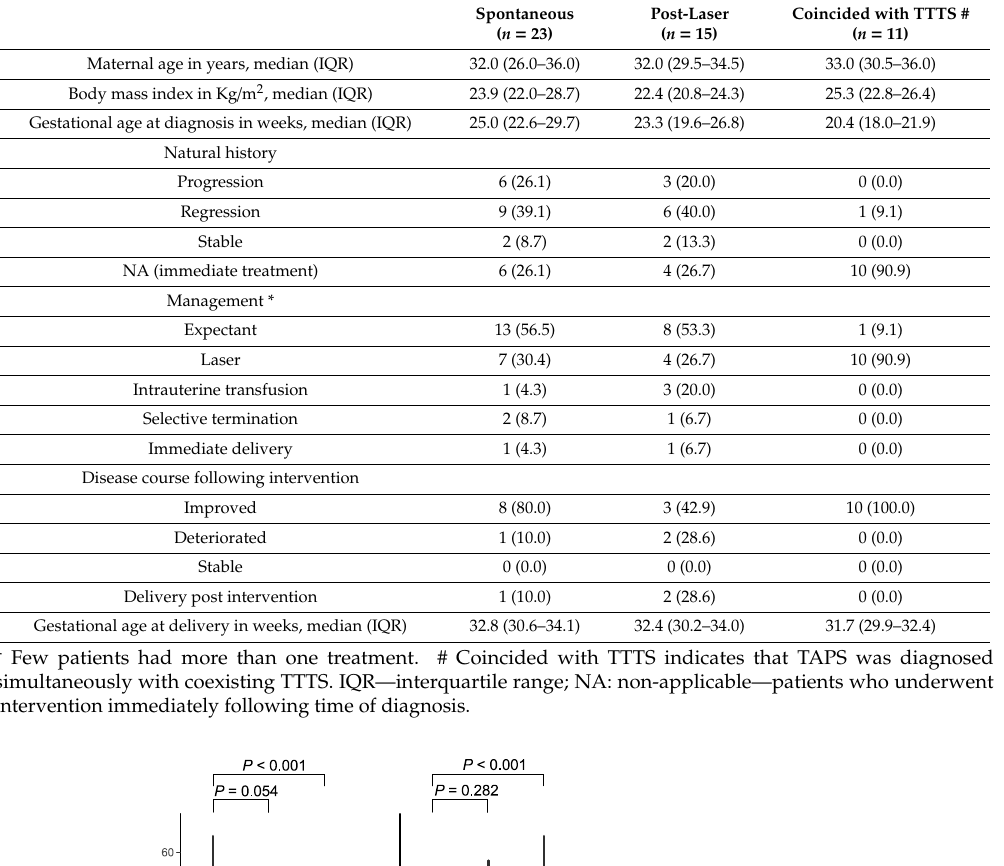
Table 2. Characteristics, natural history, intervention, and disease course following intervention in spontaneous onset TAPS, post-laser, and TAPS coincided with TTTS.